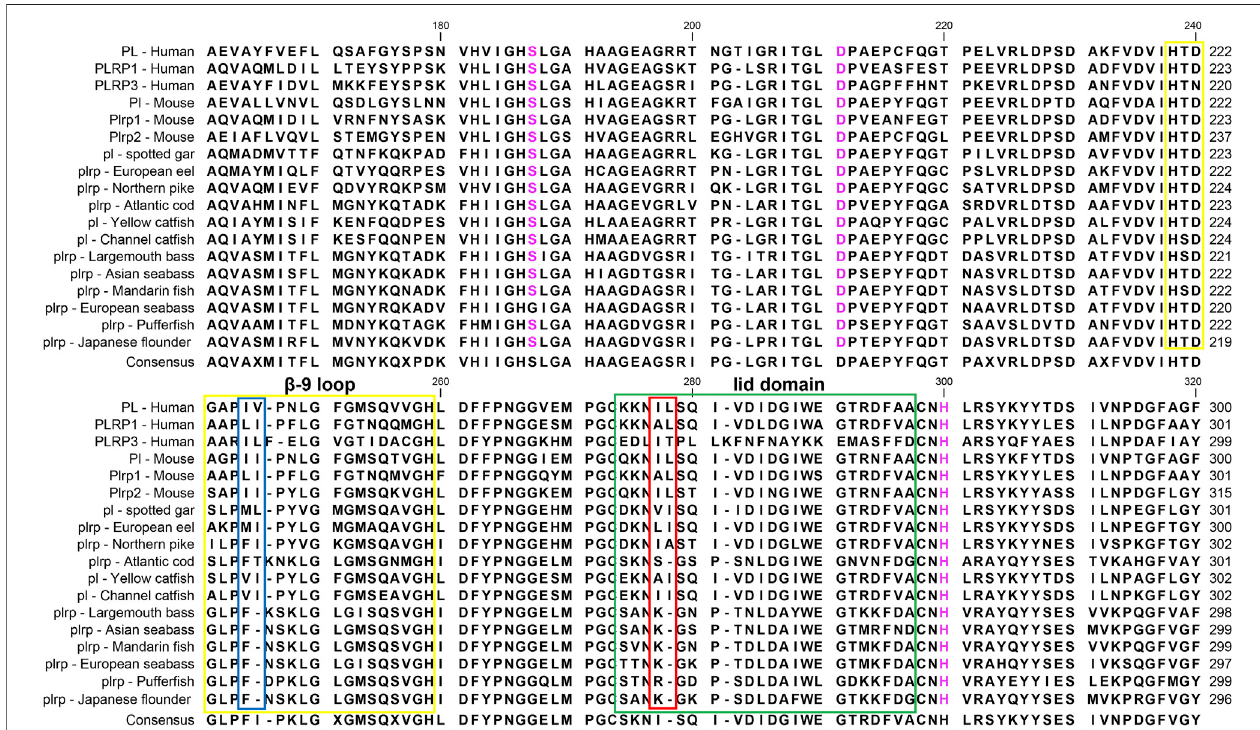
FIGURE5| Partialaminoacidsequencealignmentsofpancreaticlipasesforhumansand fi shes.Boxesingreenandyellowrepresenttheliddomainand β -9loopof pancreatic lipase, respectively. Active site triad residues Ser, Asp, and His weremarked with pink. The red and blue boxes represent the absence ofIle and Leu in the lid domainand β -9loop,respectively.Thedashes(-)representgapsfounduponsequencealignment.Numbersrefertotheaminoacidwerelocatedattheendofeachline.